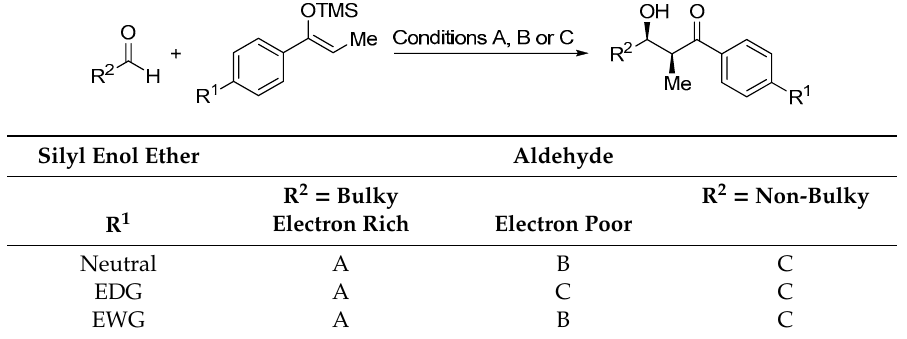
Silyl Enol Ether Aldehyde Silyl enol ether Aldehyde R 2 = bulky R 2 = non-bulky R 1 Electron rich